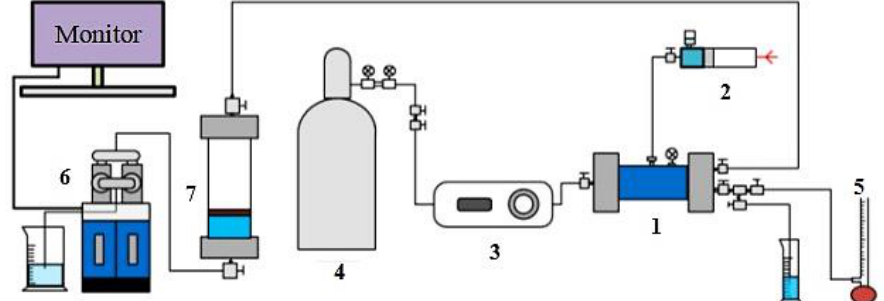
Figure 3. The core flooding experimental process.